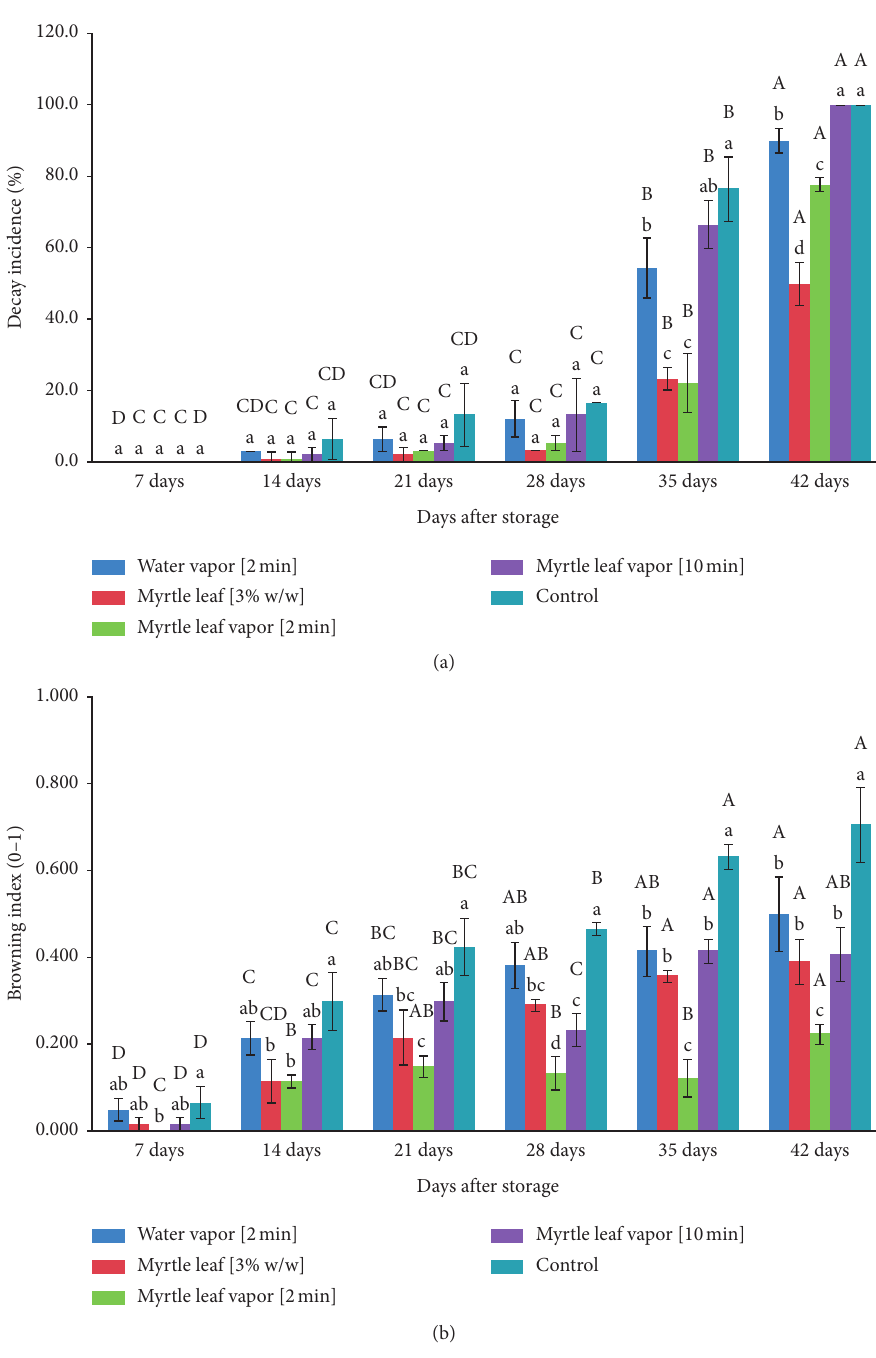
Figure 2: Effects of volatile essential oils of myrtle leaves on the (a) decay incidence and (b) browning index of loquat fruits during 42 days of storage. Different lowercase letters denote significant differences among different treatments for the same sampling time; and different capital letters denote significant differences among different sampling times for the same treatment, according to Tukey’s HSD test at P < 0 .